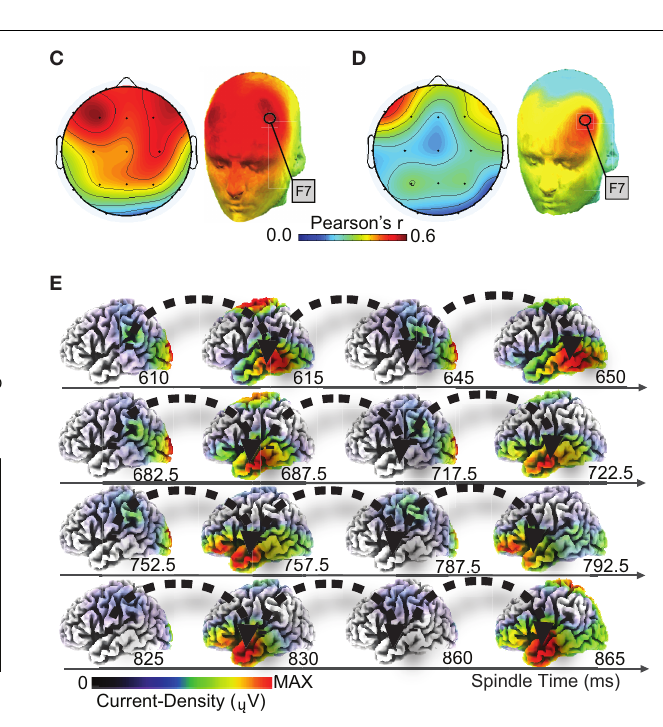
FIGURE 3 | (A) Episodic learning ability (% face-name pairs encoded) in the nap and non-nap group at 12:00 and 18:00 (left), and the change in episodic learning ability between sessions (18:00–12:00; right). Episodic learning ability in a subset of nap and no-nap subjects ( n = 10 per group), matched on initial 12:00 performance, is presented in the center box. Comparisons (line across bars) in both plots reflect significance* at: p < 0.05. Error bars represent S.E.M. (B) Within the nap group, correlations with stage-2 NREM sleep and episodic learning ability at 12:00 (left-panel), 18:00 (middle-panel), and the change in learning ability between session (18:00–12:00; right-panel). (C)